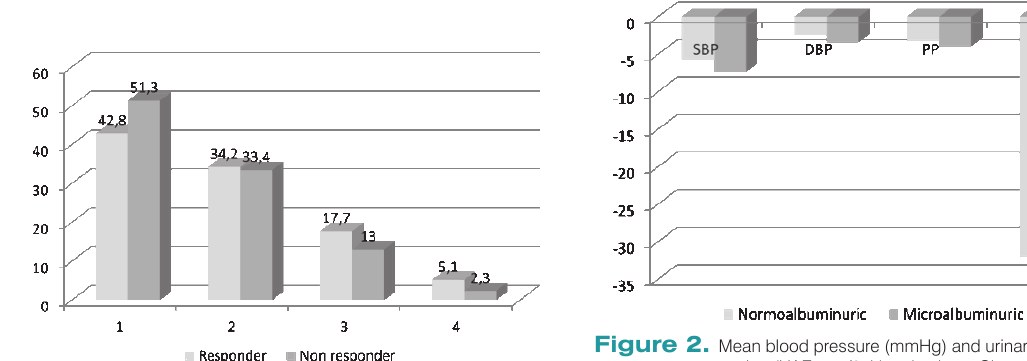
Table 2. Blood pressure before treatment